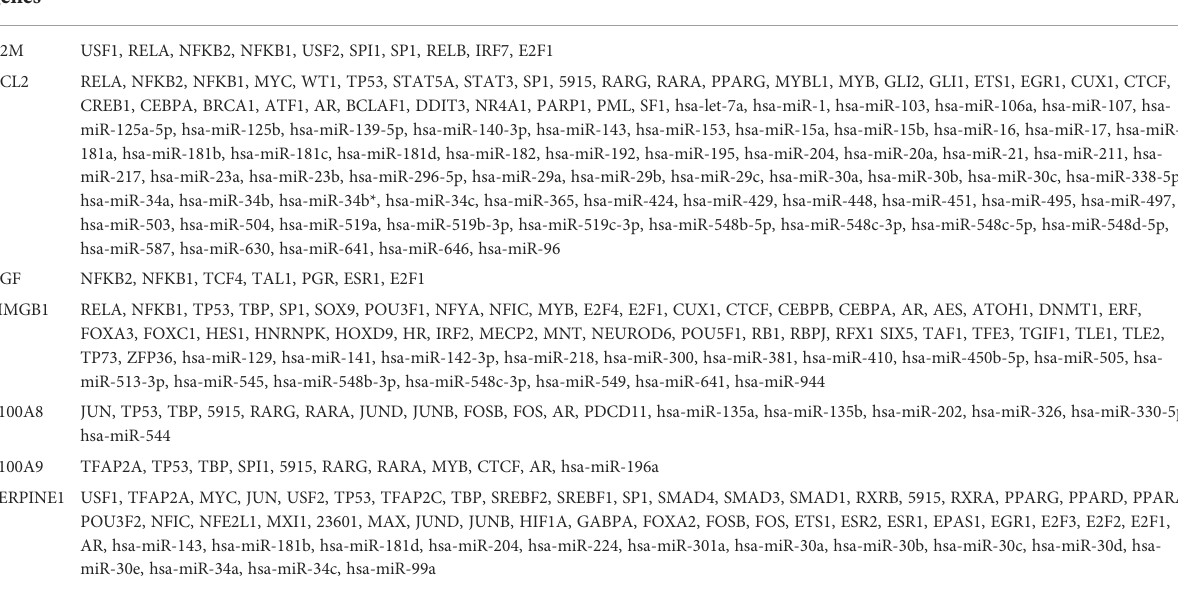
TABLE 5 TF – miRNA coregulatory interaction. Hub genes